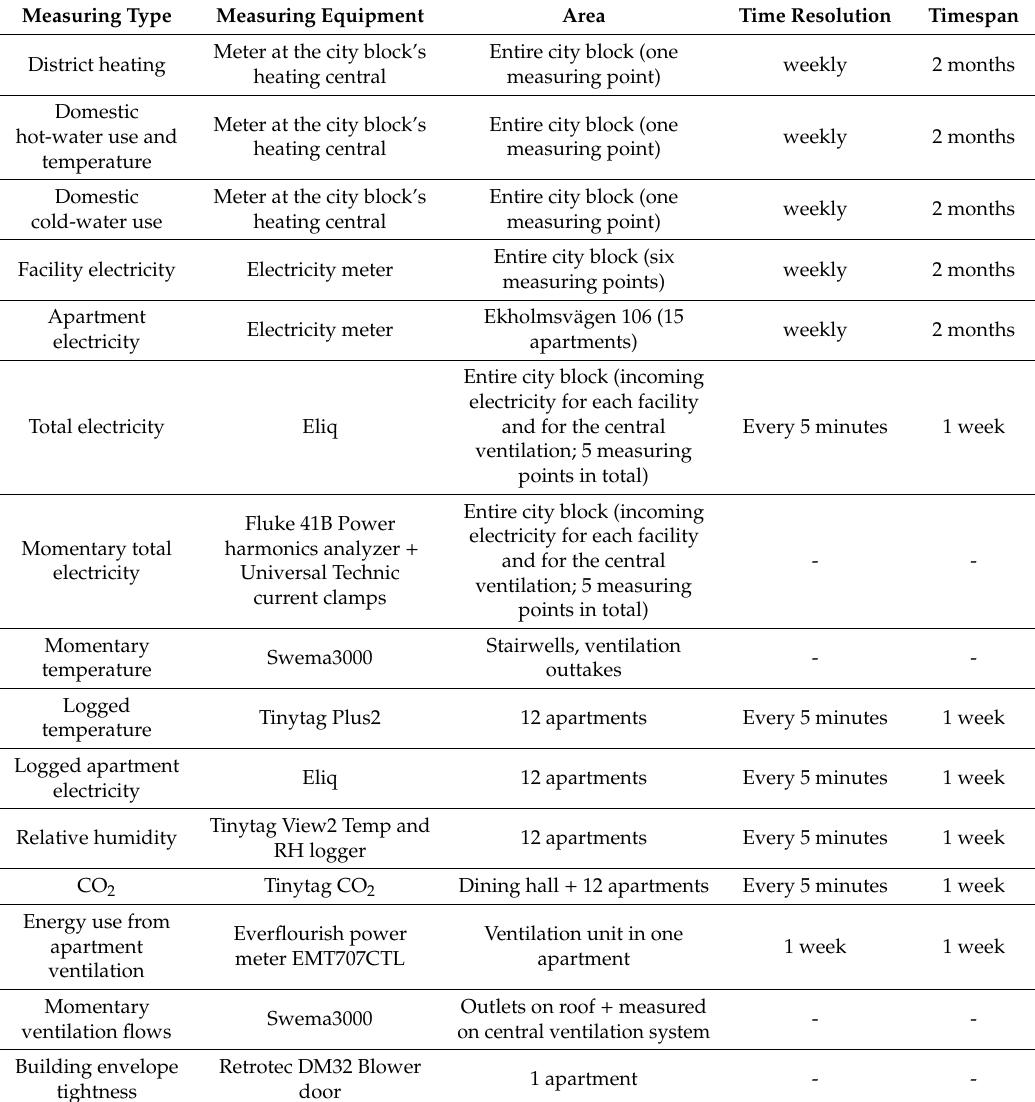
Table 4. Measurements at the city block and the modeled building, time resolution, and time span, as well as which measurement equipment was